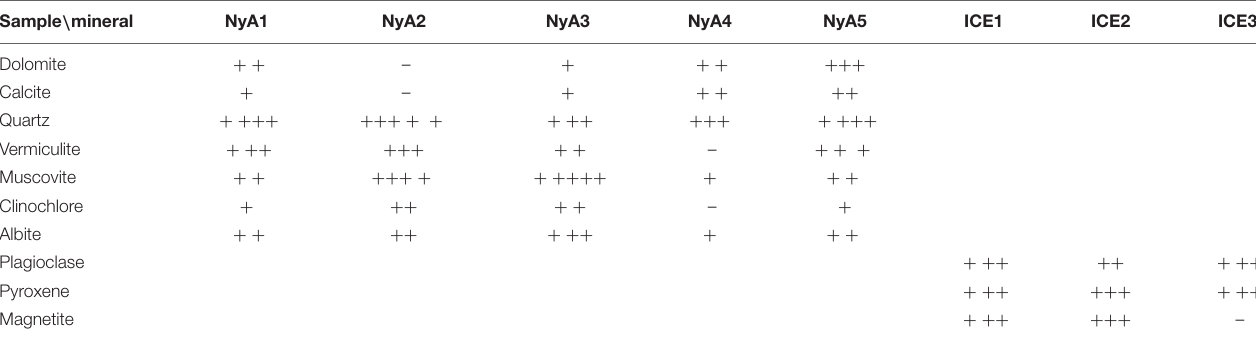
TABLE 4 | Raw estimation of phase amounts in the samples, based on the relative intensities of XRD reflections. Sample \